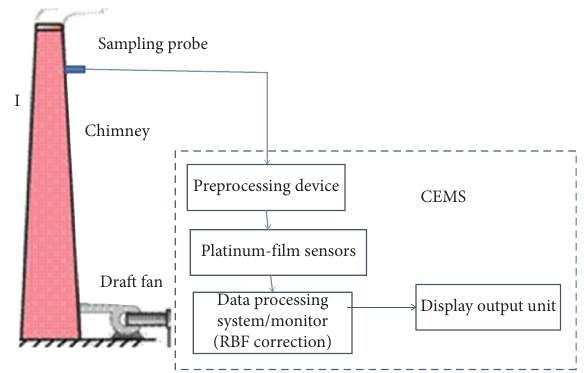
Figure 1: Schematic diagram of the experimental